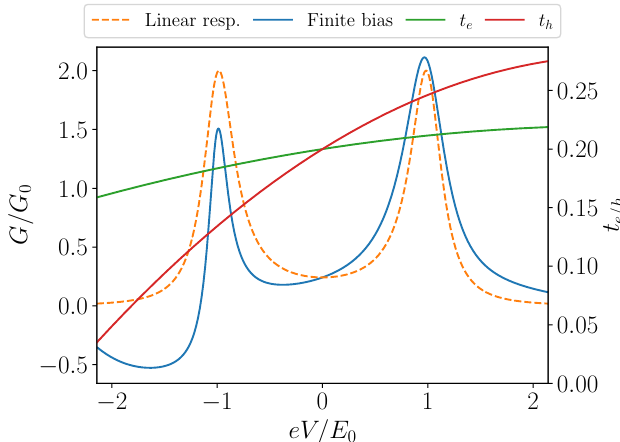
Figure 2: Two-terminal NS conductance into a single Andreev bound state with a scattering region sensitive to the applied bias voltage. In the linear response ap- proximation the voltage dependence of the scattering region is neglected, resulting in particle-hole symmetric conductance profiles (orange dashed lines). When a volt- age dependence is included in the electron / hole tunneling amplitude t solid lines), the corresponding conductance profiles (blue solid lines) show different heights and widths at positive and negative bias